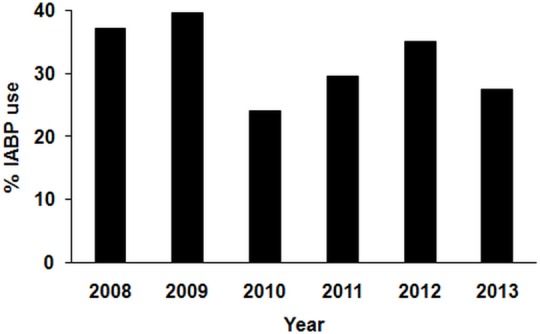
Trends in IABP use over the study period (2008–2013).